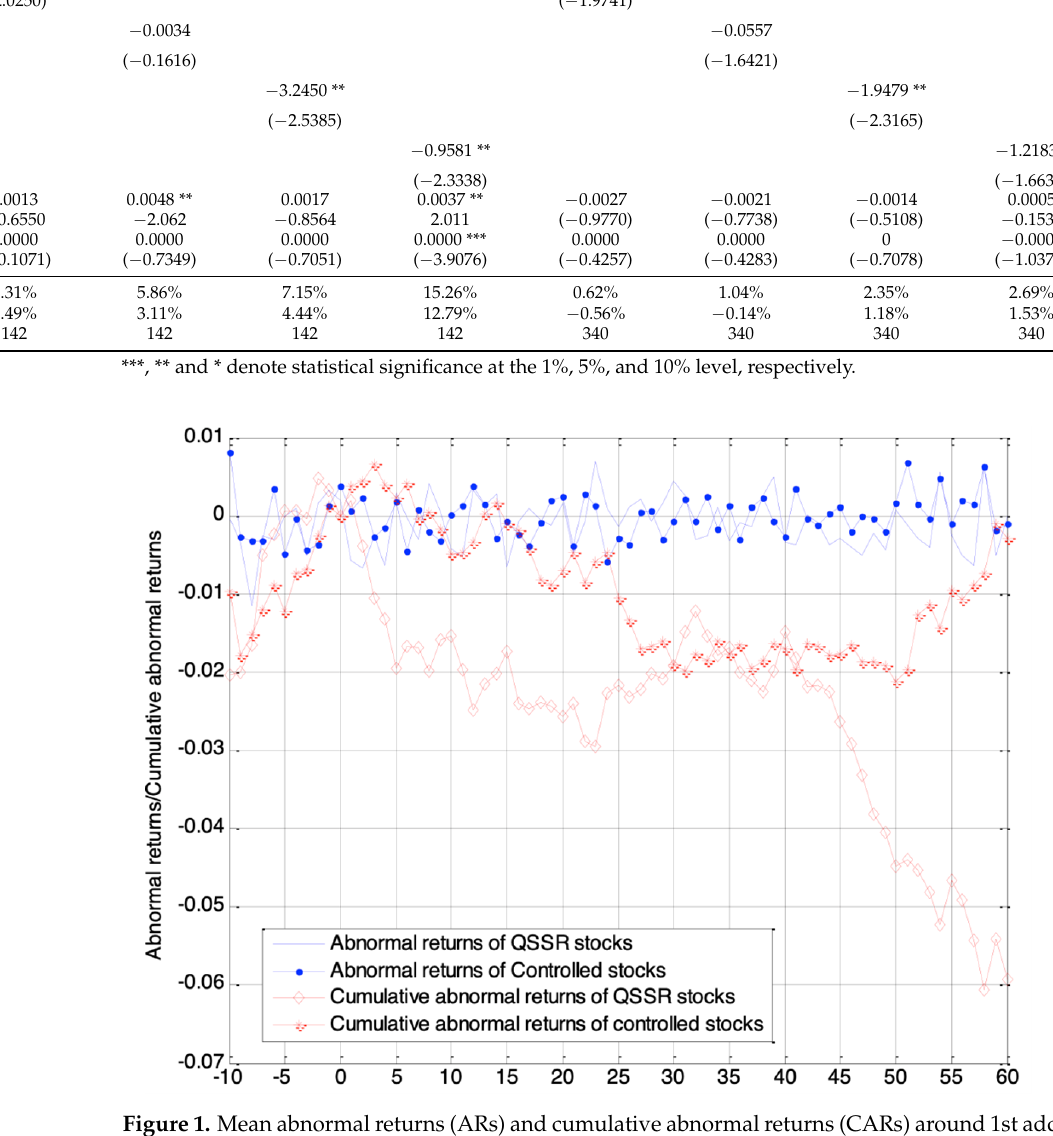
Figure 1. Mean abnormal returns (ARs) and cumulative abnormal returns (CARs) around 1st addition to the QSSR